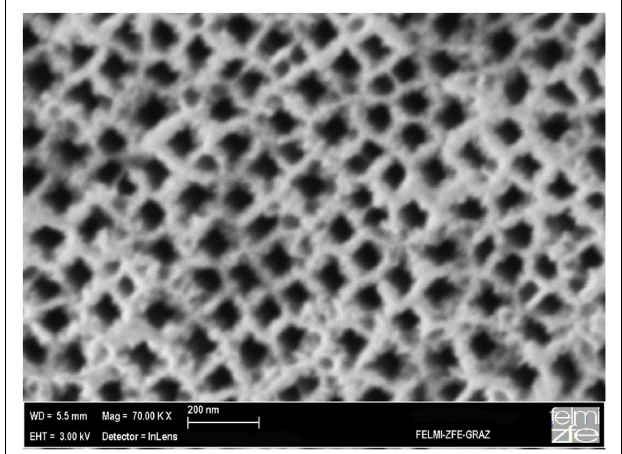
FIGURE 1 |The top-view SEM image of a porous silicon sample shows pores with an average diameter of 60nm and a mean distance between the pores of 40nm .